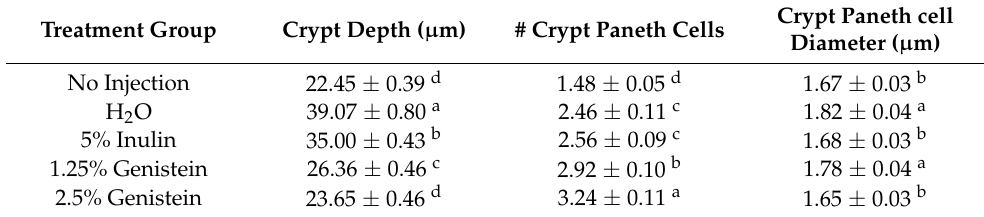
Table 7. Effects of genistein intraamniotic administration on crypt depth and Paneth cells 1